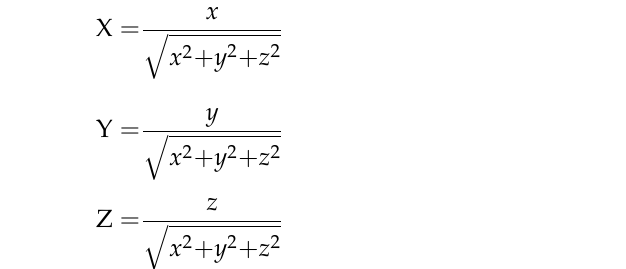
O ′ uv H Figure 5. Cross-section of the UV plane and sphere when the stereographic projection is used. In the stereographic projection, f M ( m, n ) from (6) is implemented by substituting (20) and (21) into (14) and (15). After ( u, v ) has been derived by using f M ( m, n ), it can be rep- resented with 3D coordinates ( x, y, z ) by applying (16). When the stereographic projec- tion is used, the 3D coordinates of P ’ are as follows: X=